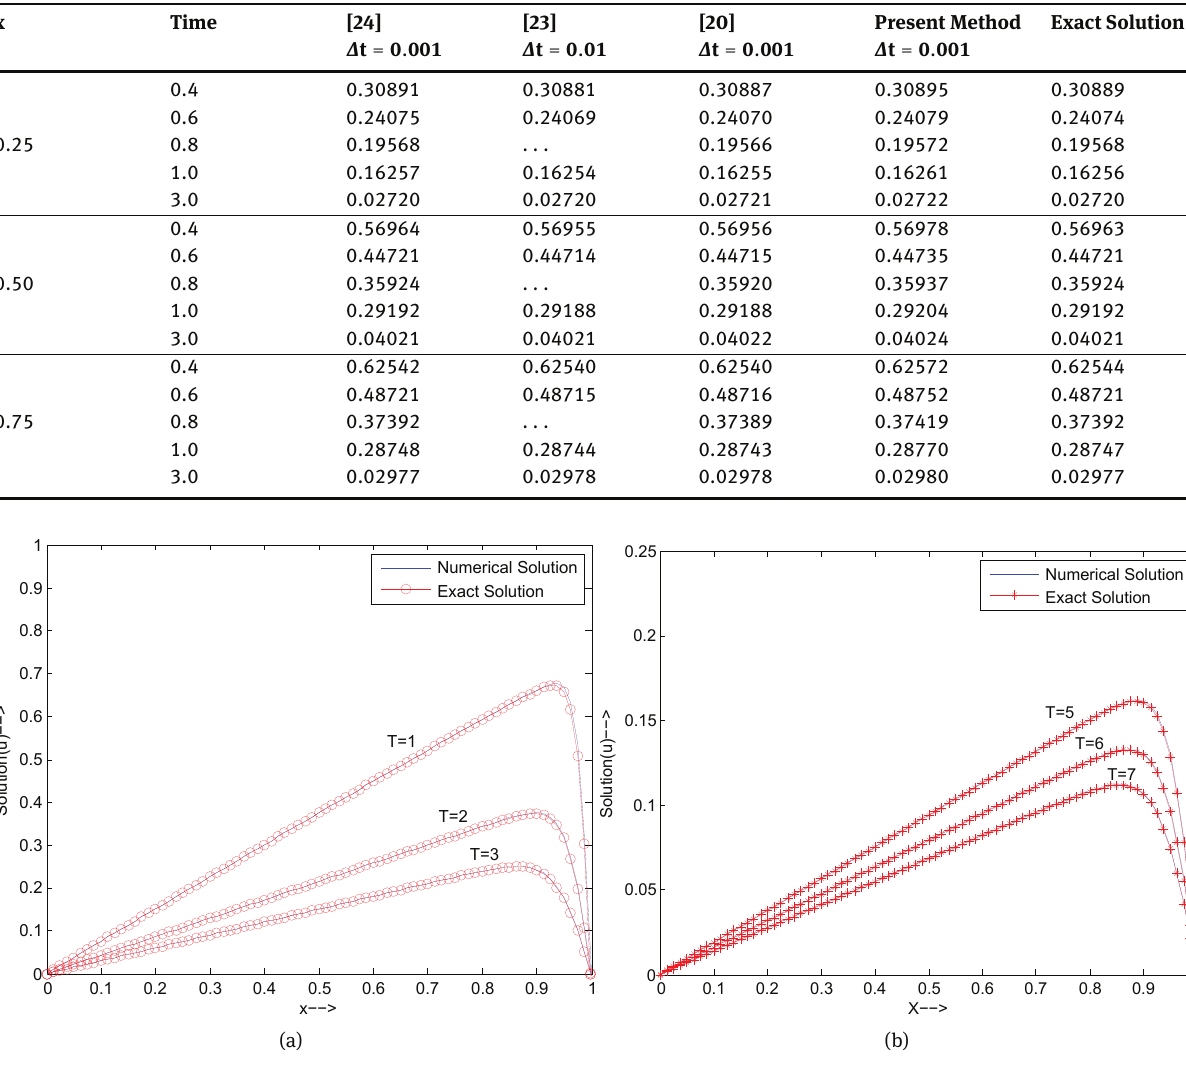
Fig. 3: Numerical solutions of Example 1 at different times for Δx = 0.0125 and different values of ν and Δt , (a) ν = 0.01 , Δt = 0.001 (b) ν = 0.005 , Δt = 0.001